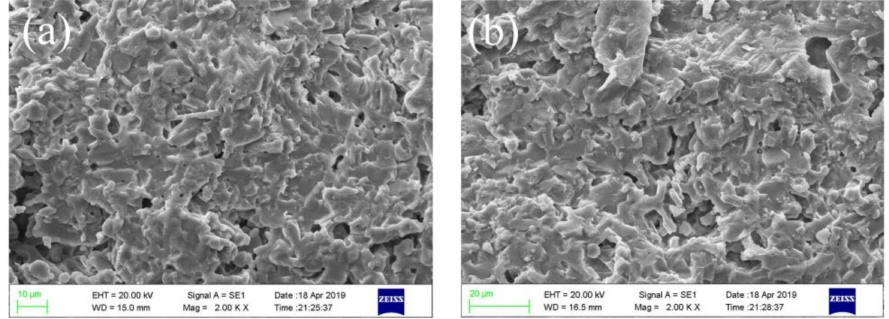
Figure 9. Fracture morphology of alumina coating under different corrosion time: ( a ) 12 h; ( b ) 48 h.